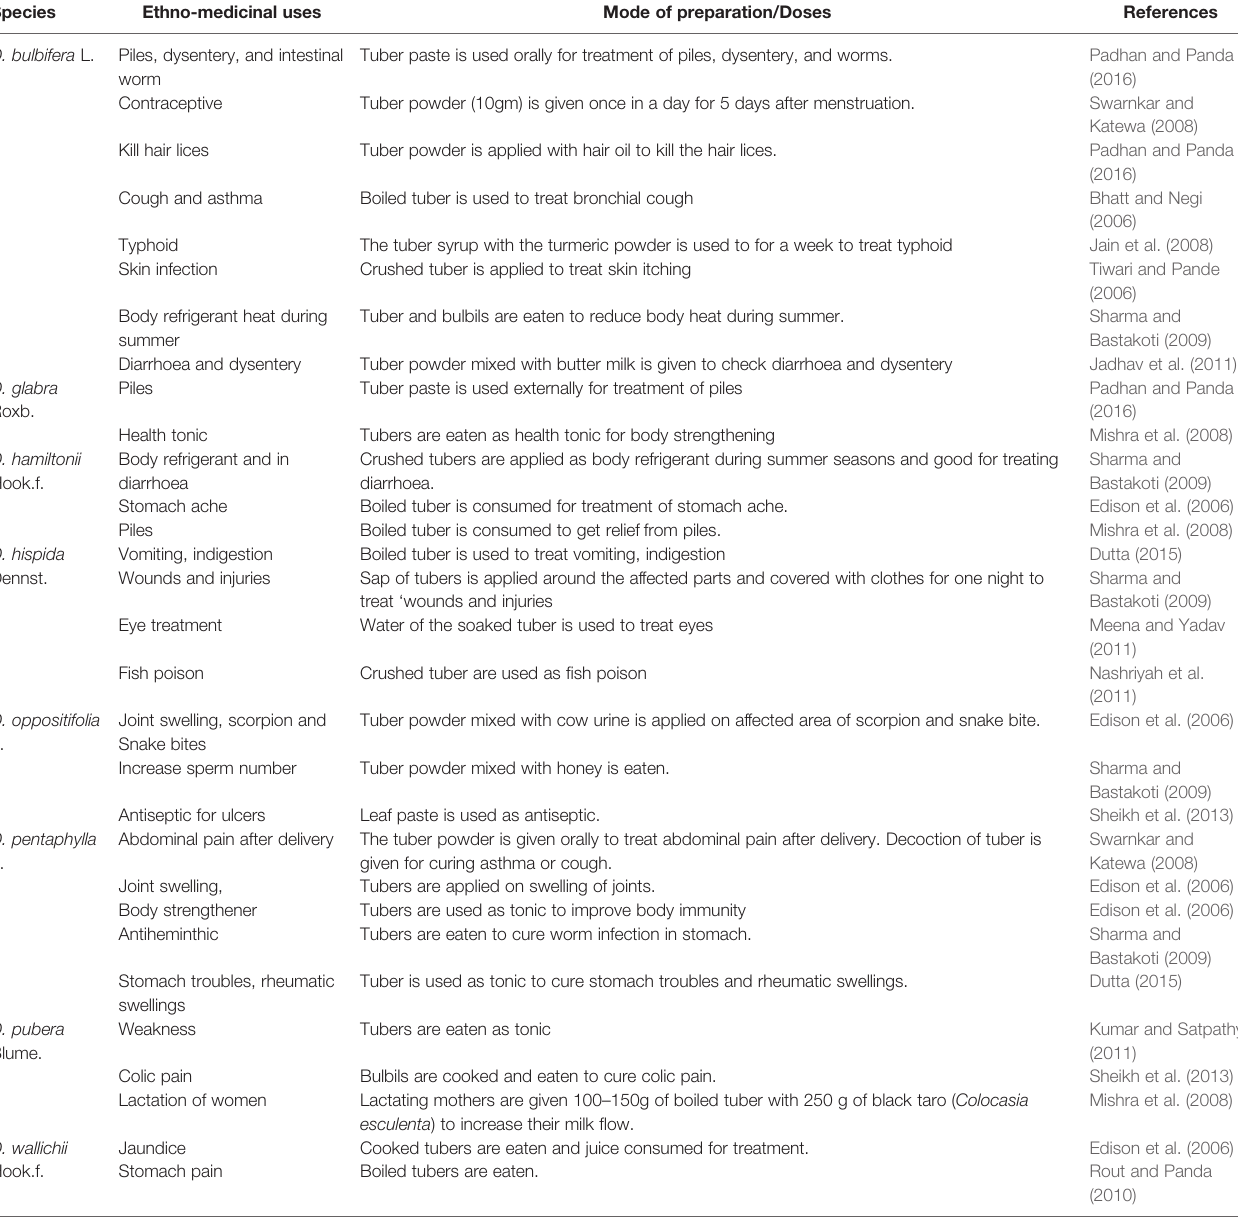
TABLE 1 | Ethno-medicinal information of different Dioscorea